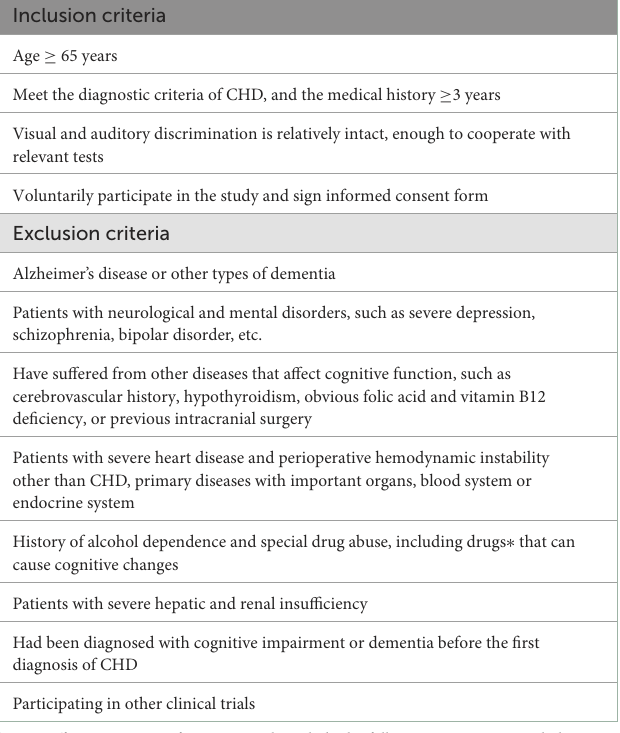
TABLE 1 Inclusion criteria and exclusion criteria of the study. Inclusion